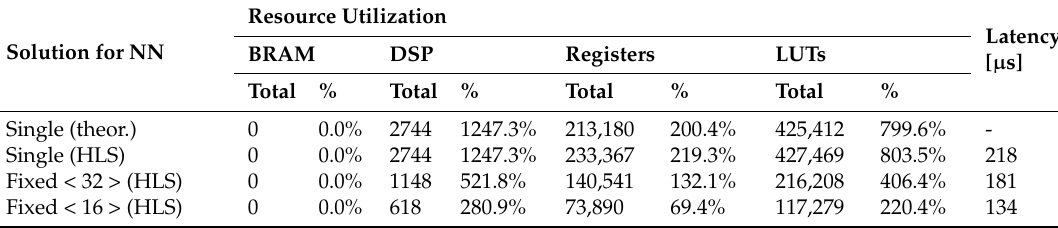
Table 6. NN inference on FPGA: fully pipelined solutions for {8, 16|12|8, 4}